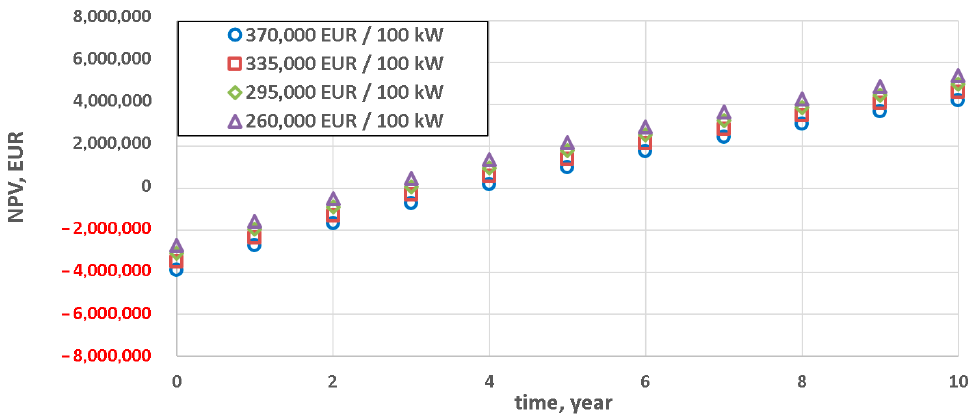
Figure 7. Results of NPV analysis for different capital expenditure levels per 100 kW of plasma torch power (at a power unit technical minimum amounting to 30% of the rated power, Y = 1, r = 9%).